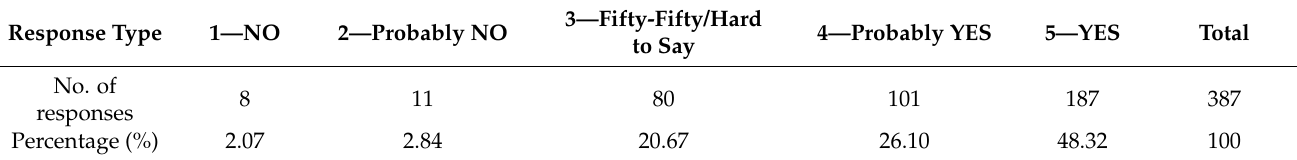
Table 6. Responses to the sixth question: Do you know what cryptocurrencies